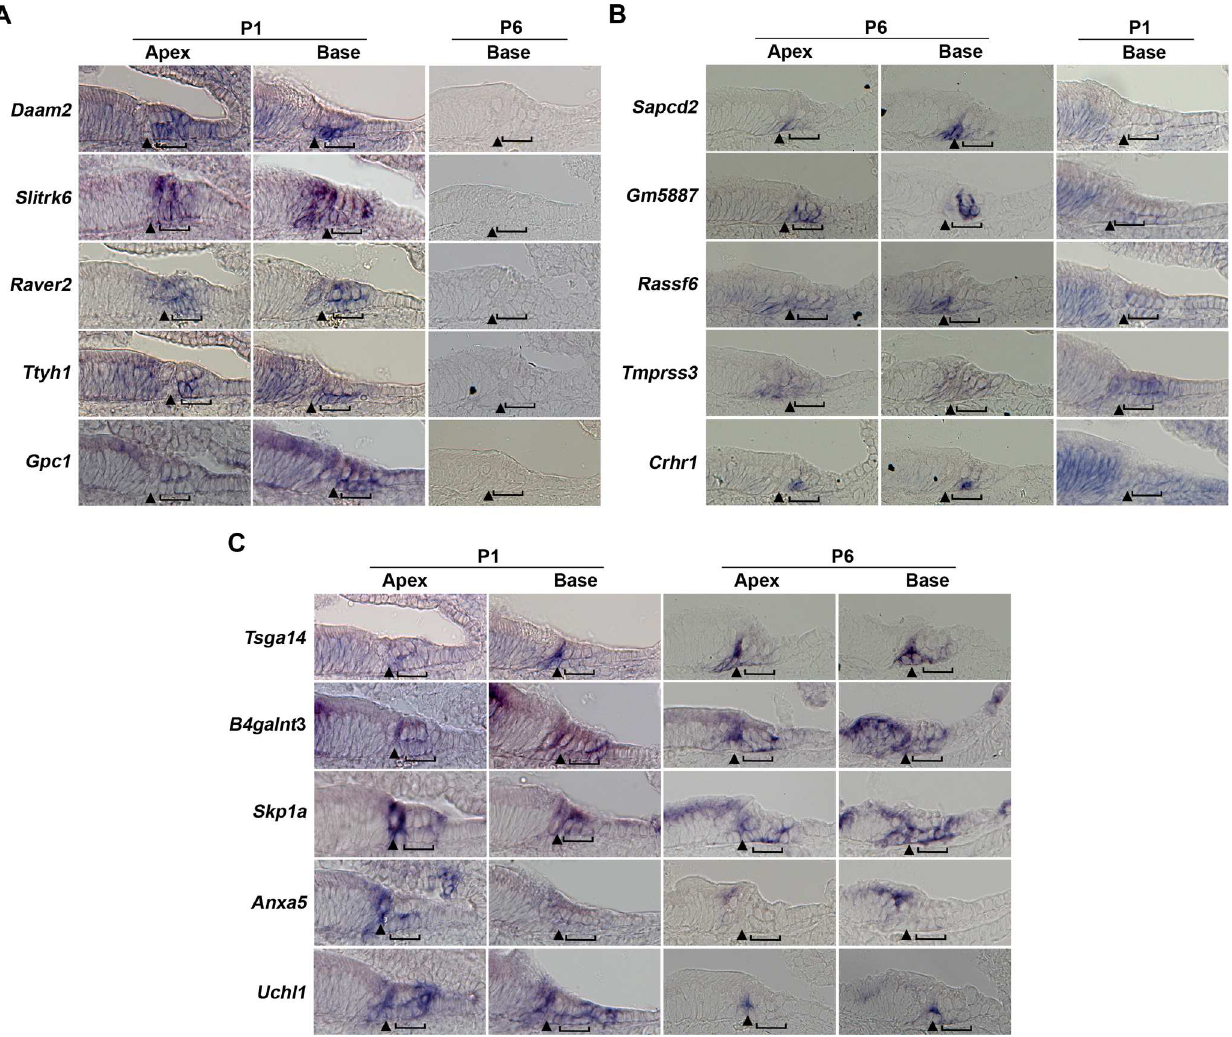
Fig 2. In situ validation of supporting cell-specific transcripts. Examplesof supportingcell genes enrichedin (A) P1 supporting cells with basal P6 sections to show negativeexpression (B) P6 supporting cells with basal P1 sectionsto show negative expression (C) Both P1 and P6 supportingcells, with sections to show both apical(less mature) and basal (more mature) regionsat each age. Brackets: Deiters’ cells; Arrowhead:pillar cell region; horizontal line, greater epithelial ridge